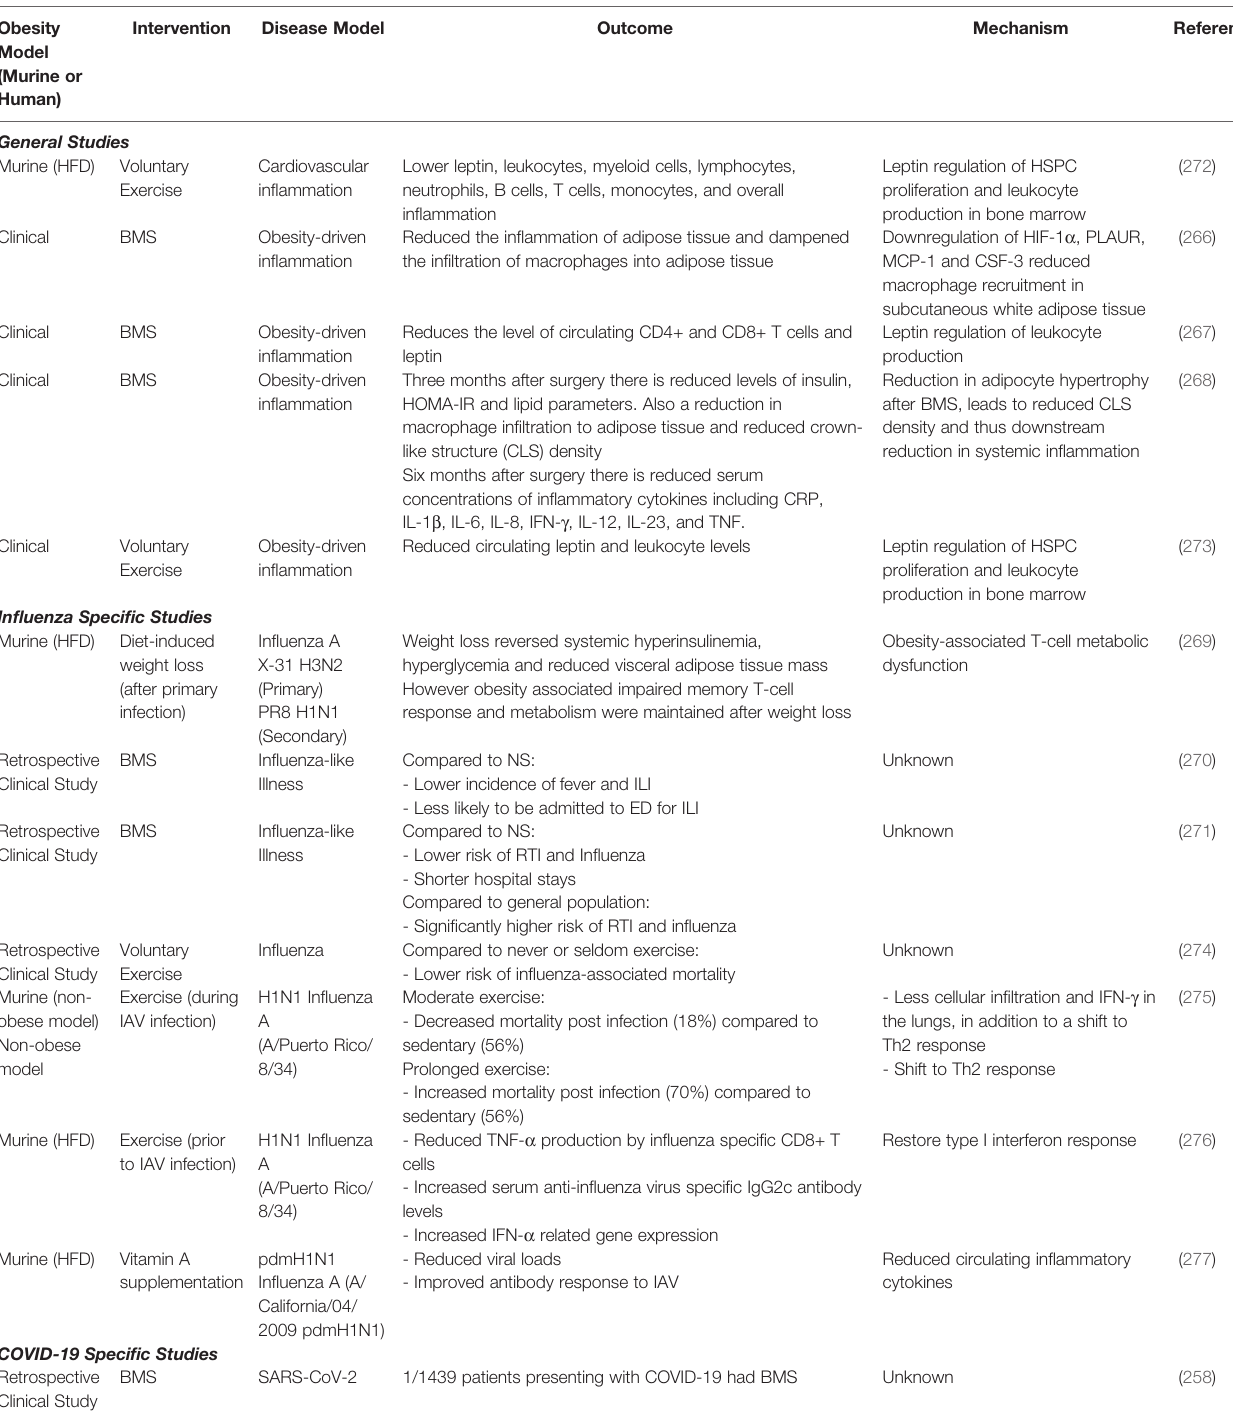
TABLE 2 | Medical and non-medical interventions to reverse long-term immune effects of